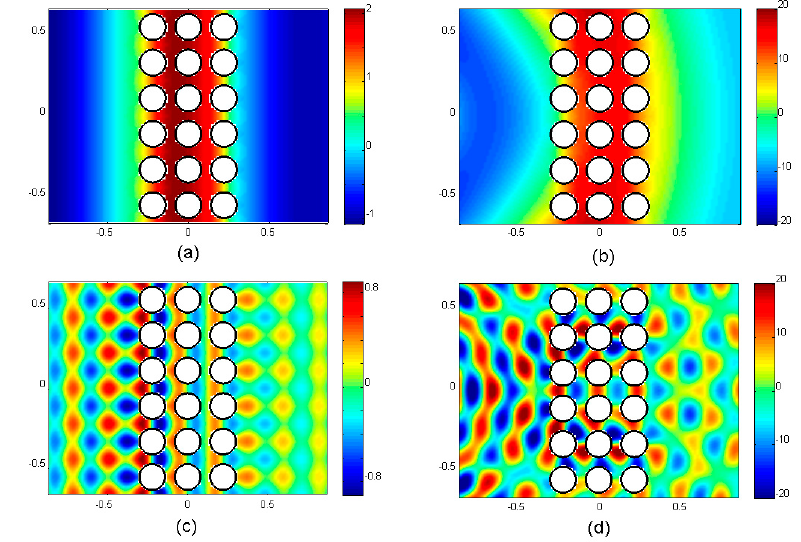
Figure 6. Snapshot of total pressure maps calculated when a plane (left panels) and a cylindrical (right panels) wave interacts with acoustic barrier consisting of three rows of rigid cylinders ordered in a square configuration with lattice constant of 22 cm and volume filling ration of 41%. ( a , b ) Calculated maps for waves with frequency of 200 Hz; ( c , d ) corresponding maps for waves with frequency of 1.55 kHz. Maps are calculated by using the finite element method.